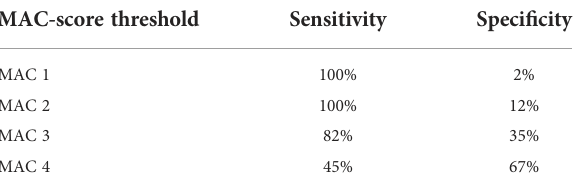
TABLE 5 Sensitivity and speci fi city for different MAC-score